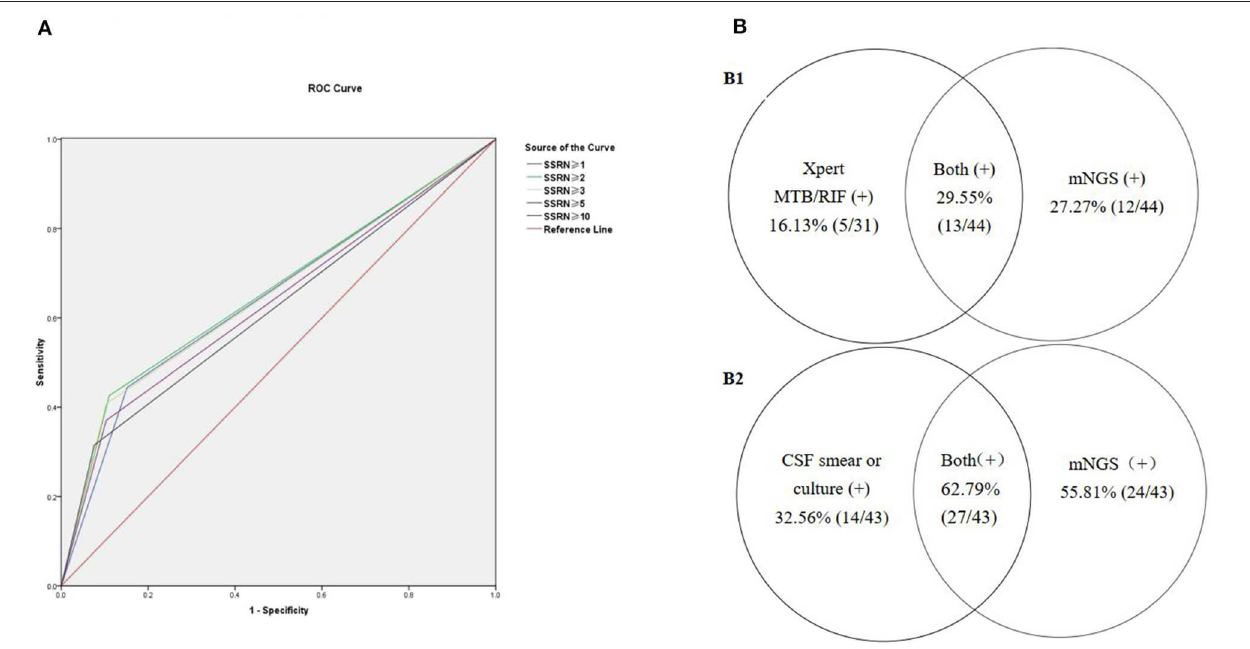
FIGURE 2 | The positive rates of mNGS combined with conventional gold microbiologic testing. (A) Receiver operating characteristic (ROC) curves for diagnosing defined viral encephalitis by mNGS. (B) Comparison of pathogens detected by mNGS compared to conventional gold standard.